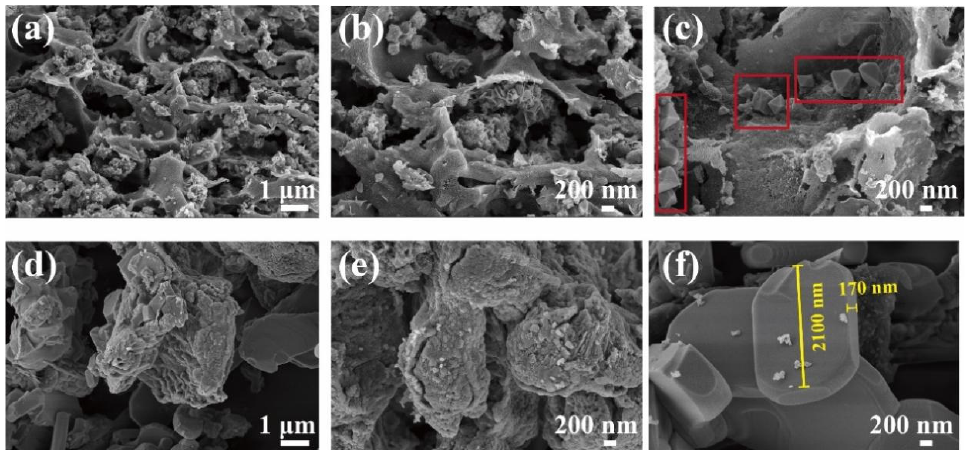
Figure 1. SEM images of MBC ( a – c ) and Ca/MBC ( d – f ).